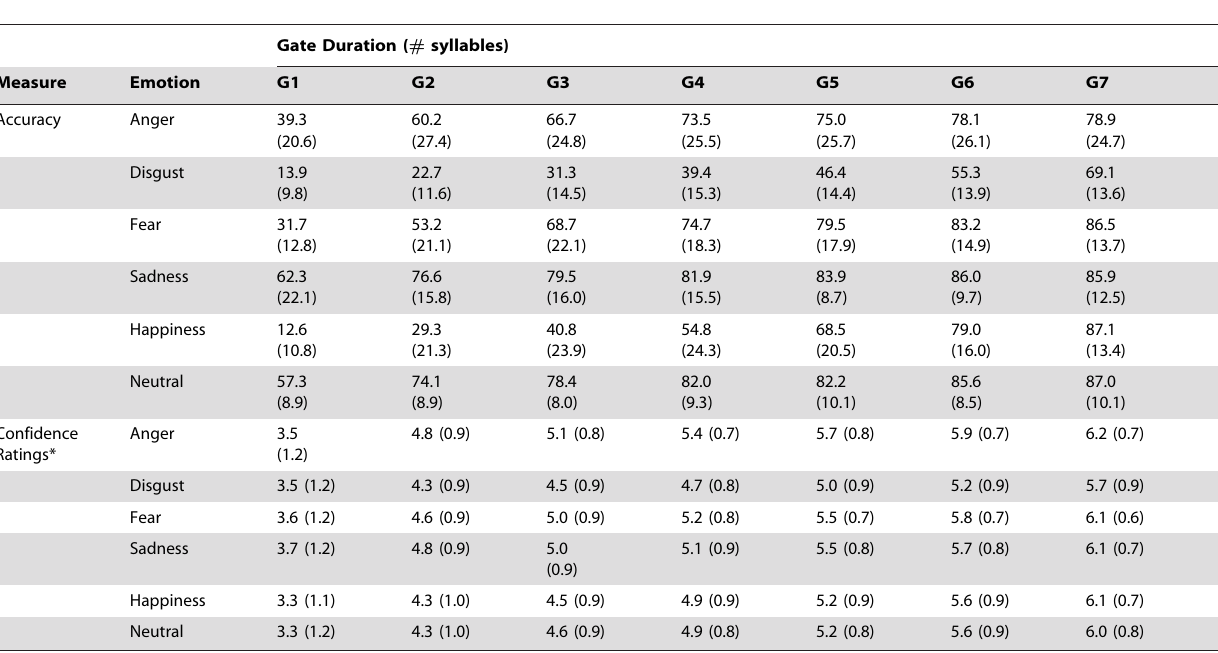
Table 2. Mean accuracy (% target recognition) and confidence ratings (scale of 1–7) for 48 listeners who judged utterances representing each emotion type, according to the gate duration.